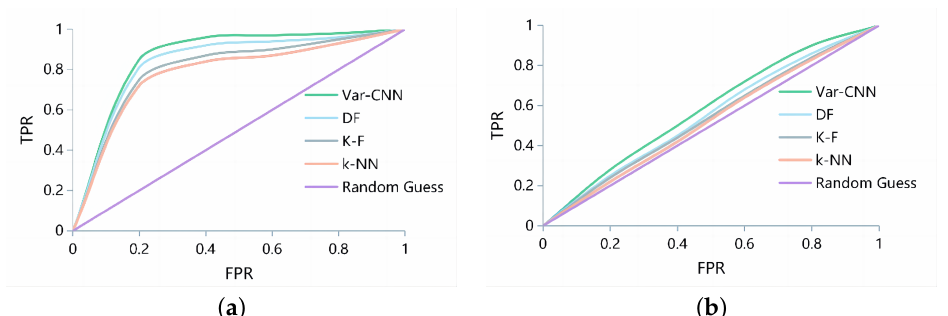
Figure 7. Changes of the state-of-the-art WFP before and after the SMART defense: ( a ) WFP in the open-world setting (undefended); and ( b ) WFP in the open-world setting (defended).